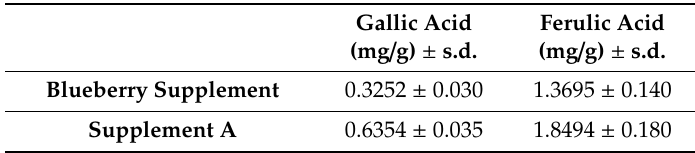
Table 1. Gallic and ferulic acid concentration analysis in two commercially available dietary supplements: Blueberry supplement and Supplement